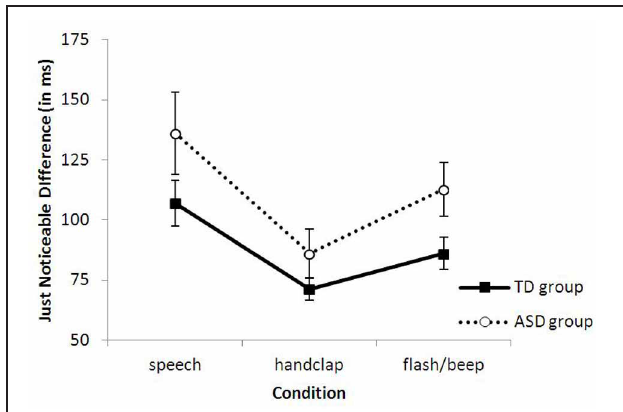
FIGURE 3 | Group-averaged JNDs as a function of the interval between the sound and video and (bars represent 1 standard error of the mean).